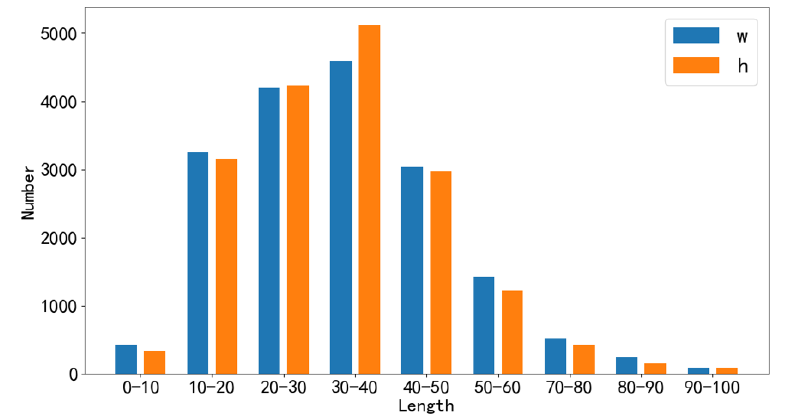
Figure 5. Size distribution map of wheat spider wites in our dataset.